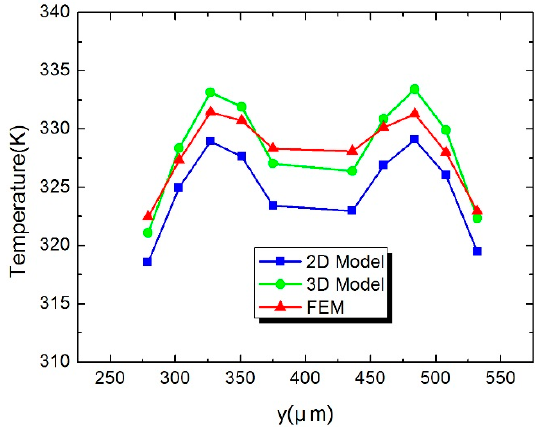
Figure 7. Temperature of hot junctions in ten thermopiles in the power sensor.